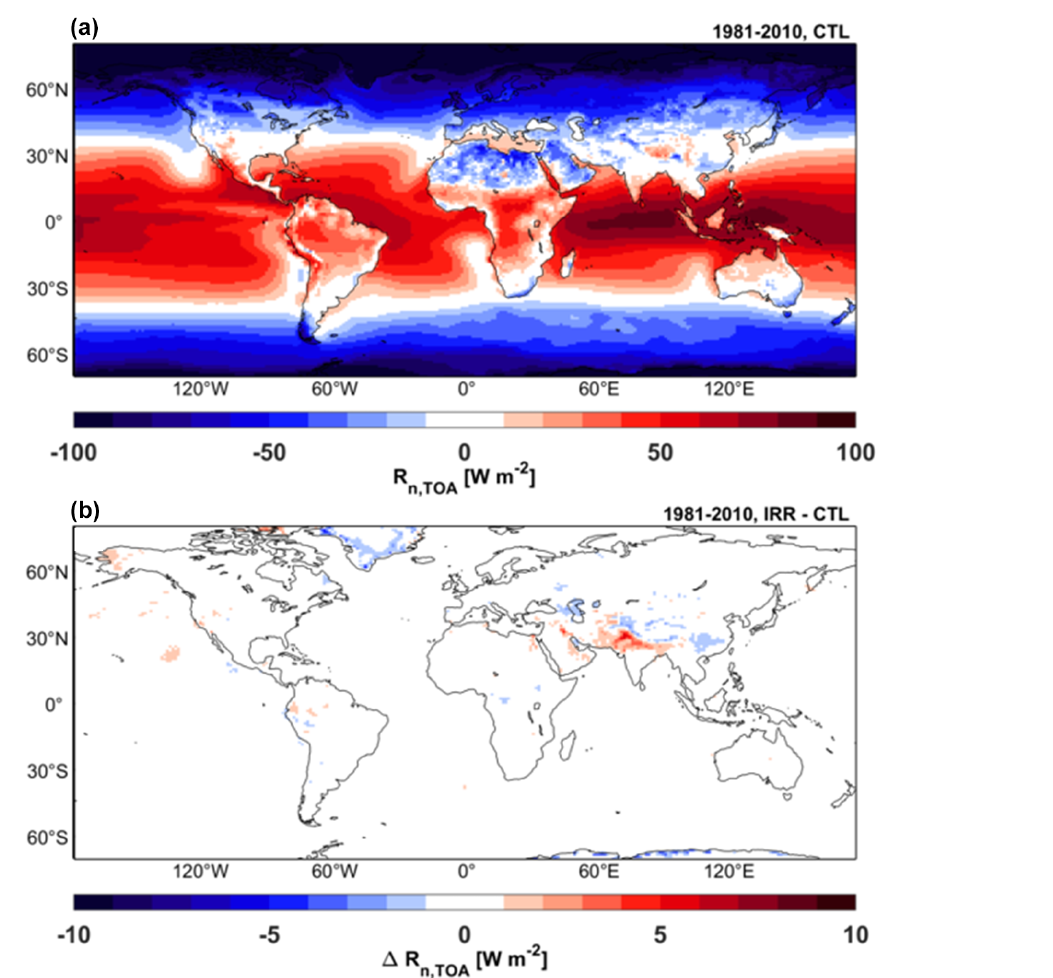
Figure 4. Top-of-atmosphere (TOA) net radiation R n , TOA [Wm − 2 ] in (a) the CTL ensemble. (b) Impact of irrigation on R n , TOA . Difference map is based on the ensemble mean of each experiment for